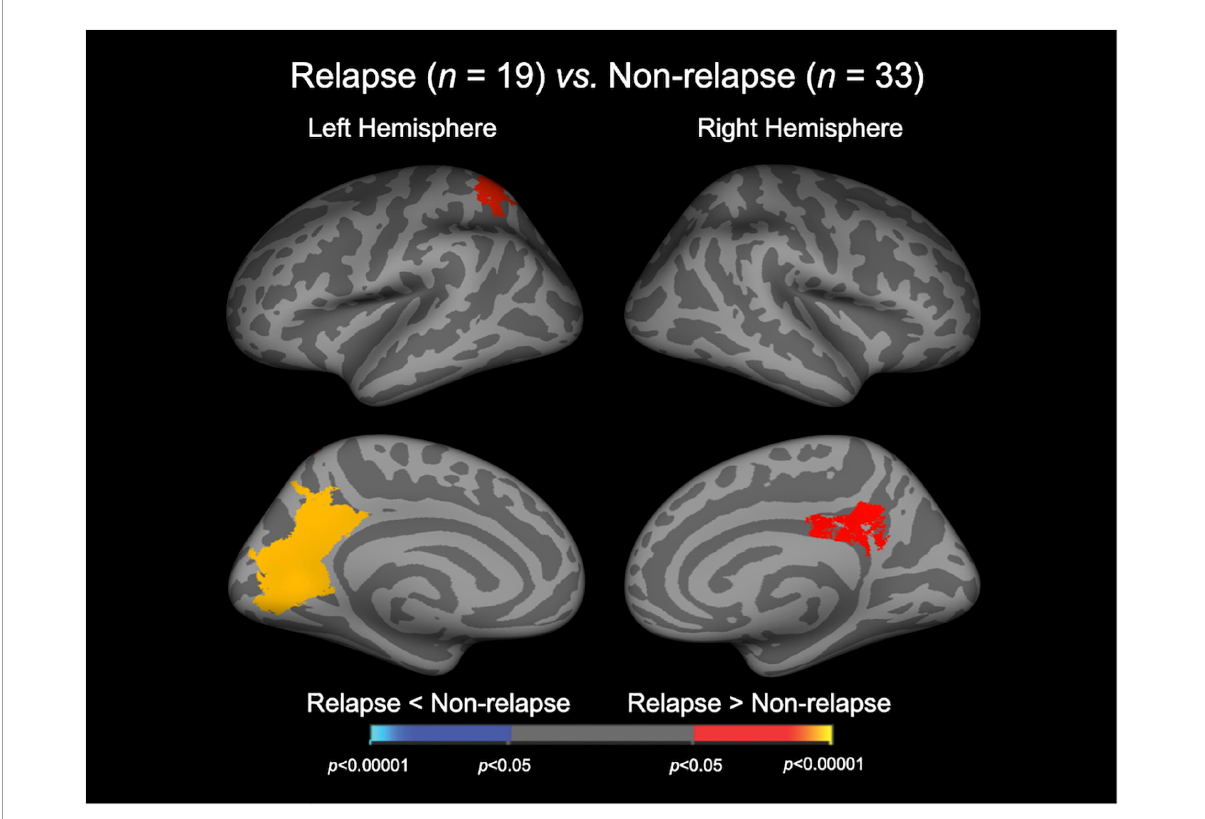
FIGURE1 Cortical statistical maps displaying the comparison of local gyrification index between relapsed and non-relapsed patients with schizophrenia. The maps are shown for the right and left hemispheres in lateral (upper) and medial (bottom) views. Horizontal bar shows p -values ( p < 0.05,